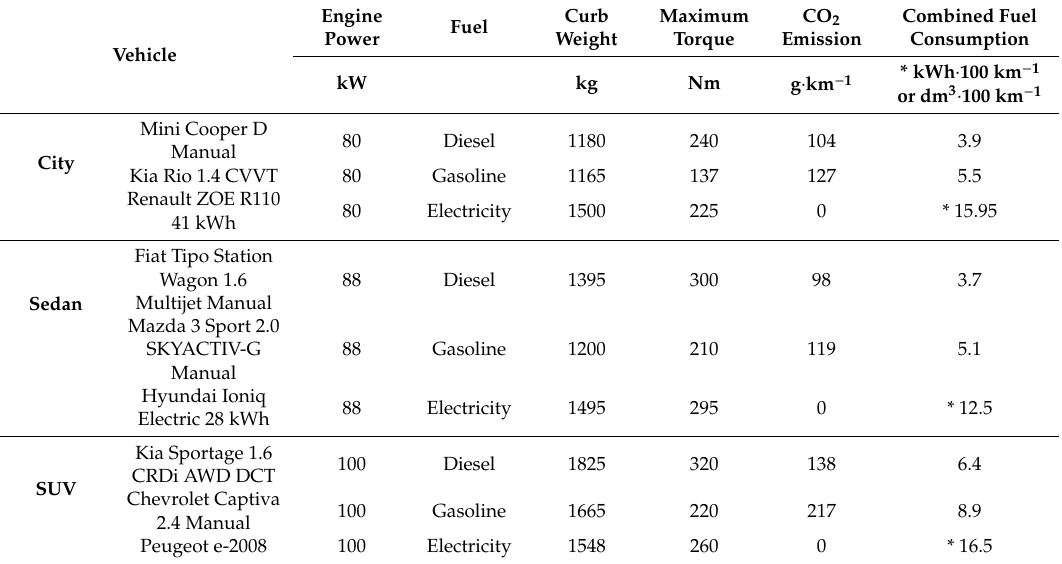
Table 2. Main car investigated in the research specifications